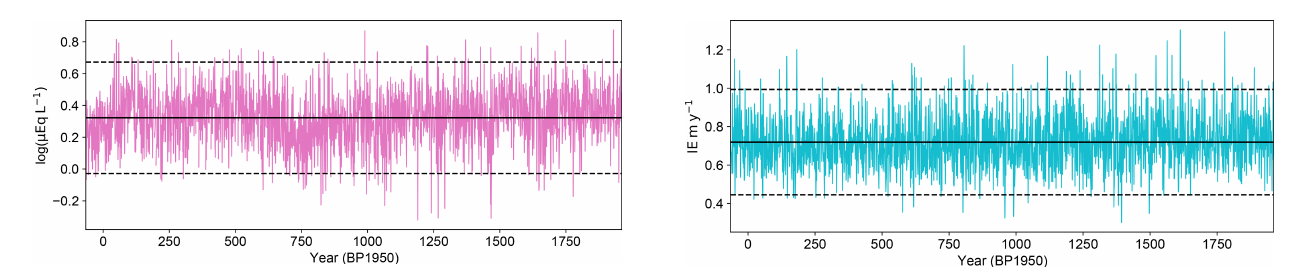
Figure 18. Time series for the annual snow accumulation rate. Solid black line indicates the 2000-year mean value. Dashed black line indicates ± 2 σ